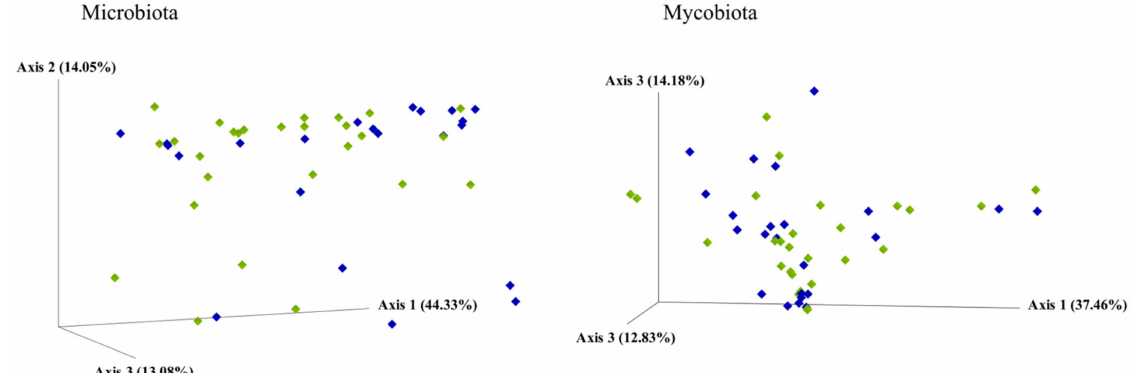
Figure 3. Principal coordinate analysis (PCoA) based on a weight UniFrac distance matrix by response to the DBPC gluten challenge test. Participants with a positive response (NCGS) are represented by green diamonds; participants with a negative response (placebo responsive) are represented by blue diamonds.